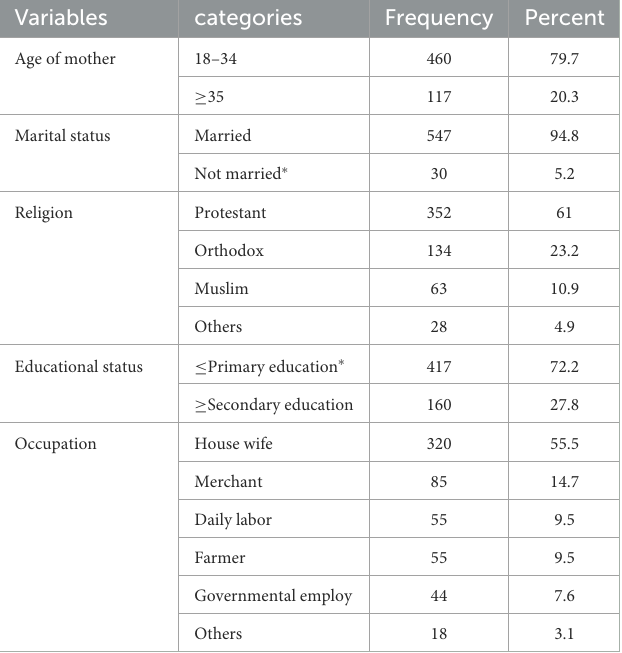
TABLE 1 Distribution of delivering women by their socio-demographic characteristics in the district areas health centers of Gedeo Zone, Southern Ethiopia 2021 ( N =